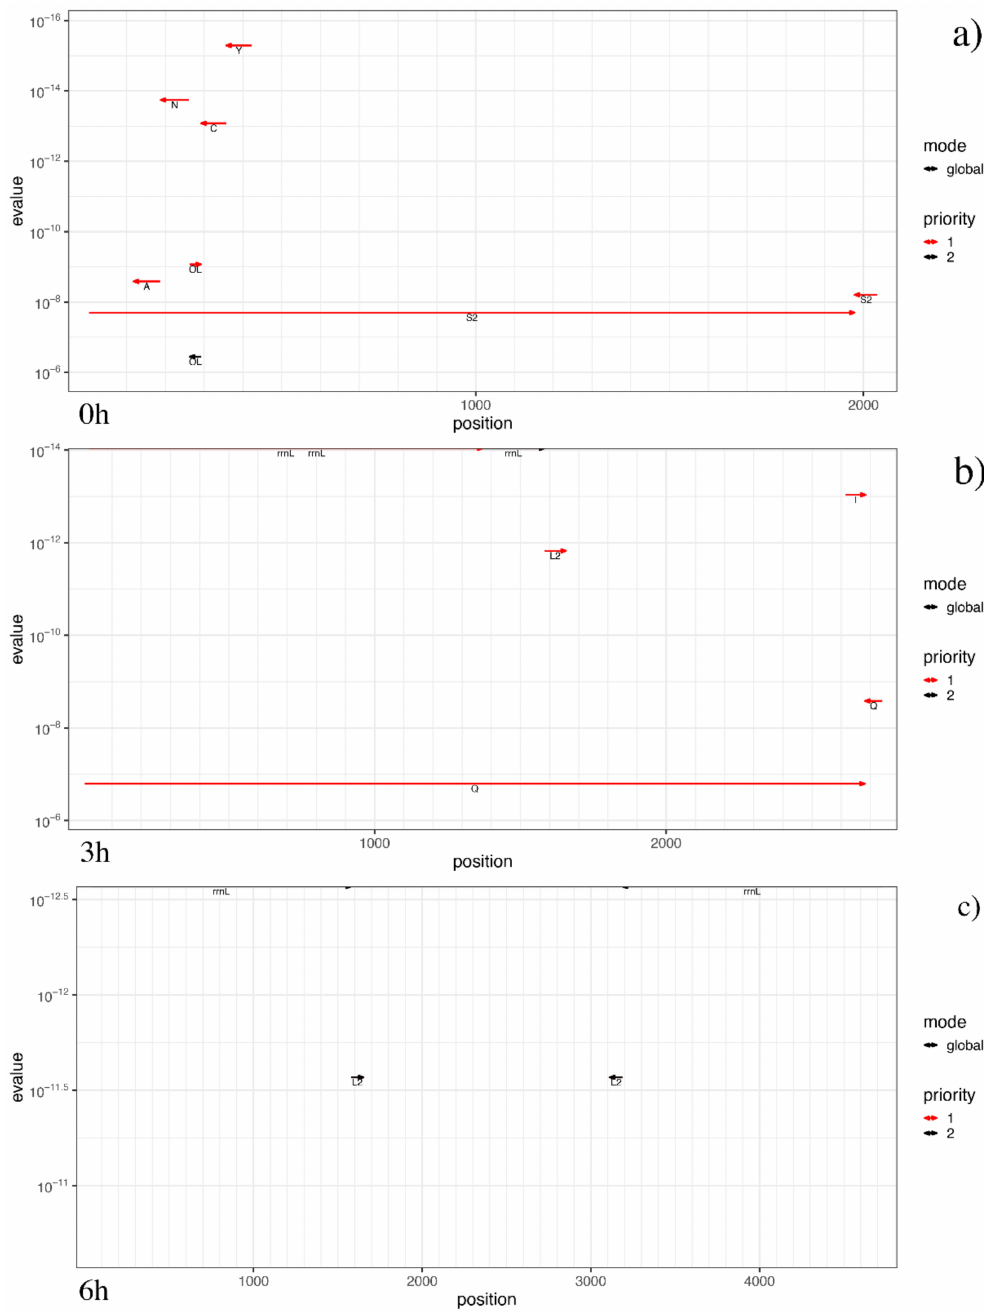
Figure 5. Non-coding RNA plots. The non-coding RNA plots show the hits from computation of rRNAs and tRNAs, di ff erentiating between the hits from the global and local (if present) search by line type. The hits are prioritized: “1” refers to features set in the first round when tools take the prediction hit of each feature, while “2” refers to all other features set afterwards in the remaining unassigned regions. Reverse log scale for the e-value was considered. The untreated sample ( a ) showed the highest number of annotated tRNAs, as well as the widest positions covered among mitogenomes, while both treated samples ( b , c ) were the most reliable in